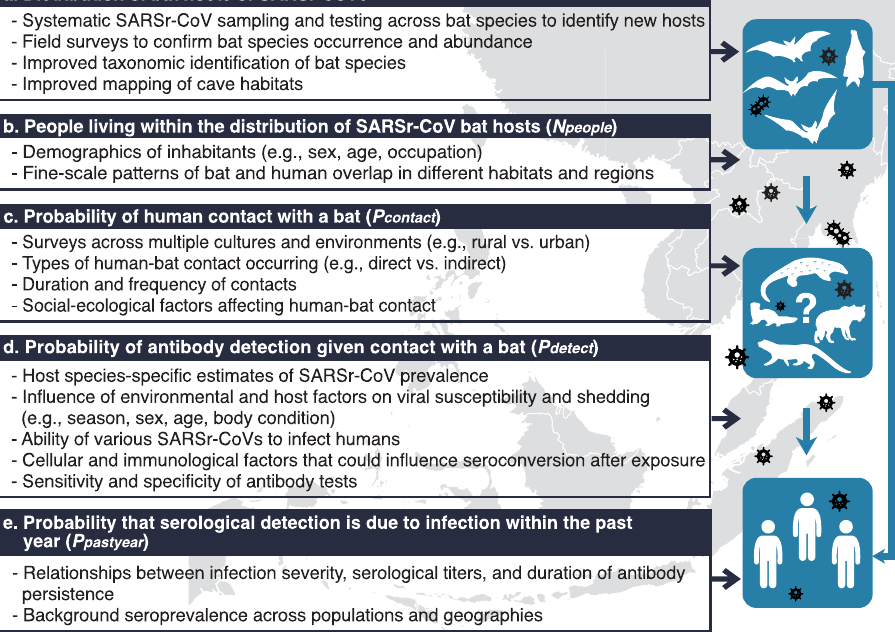
Fig. 4 Key data inputs and future research needs to improve estimates of SARSr-CoVs spillover from bats to humans. Additional data inputs are organized according to steps in our probabilistic risk assessment to improve our understanding of: a wildlife reservoir host (bat) distribution, b people overlapping with bat hosts, c probability of human-bat contact, d probability of detecting antibodies given contact, and e dynamics of antibody response in